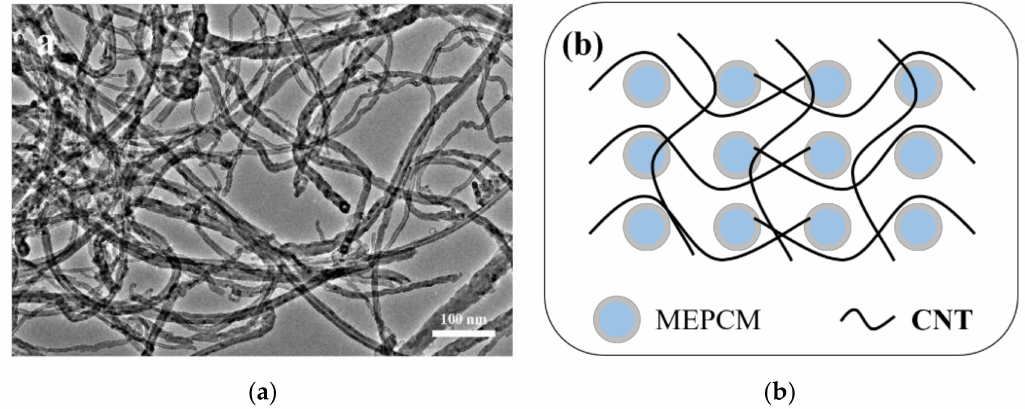
Figure 7. ( a )TEM photograph of the CTN; ( b ) Schematic illustration of the hybrid